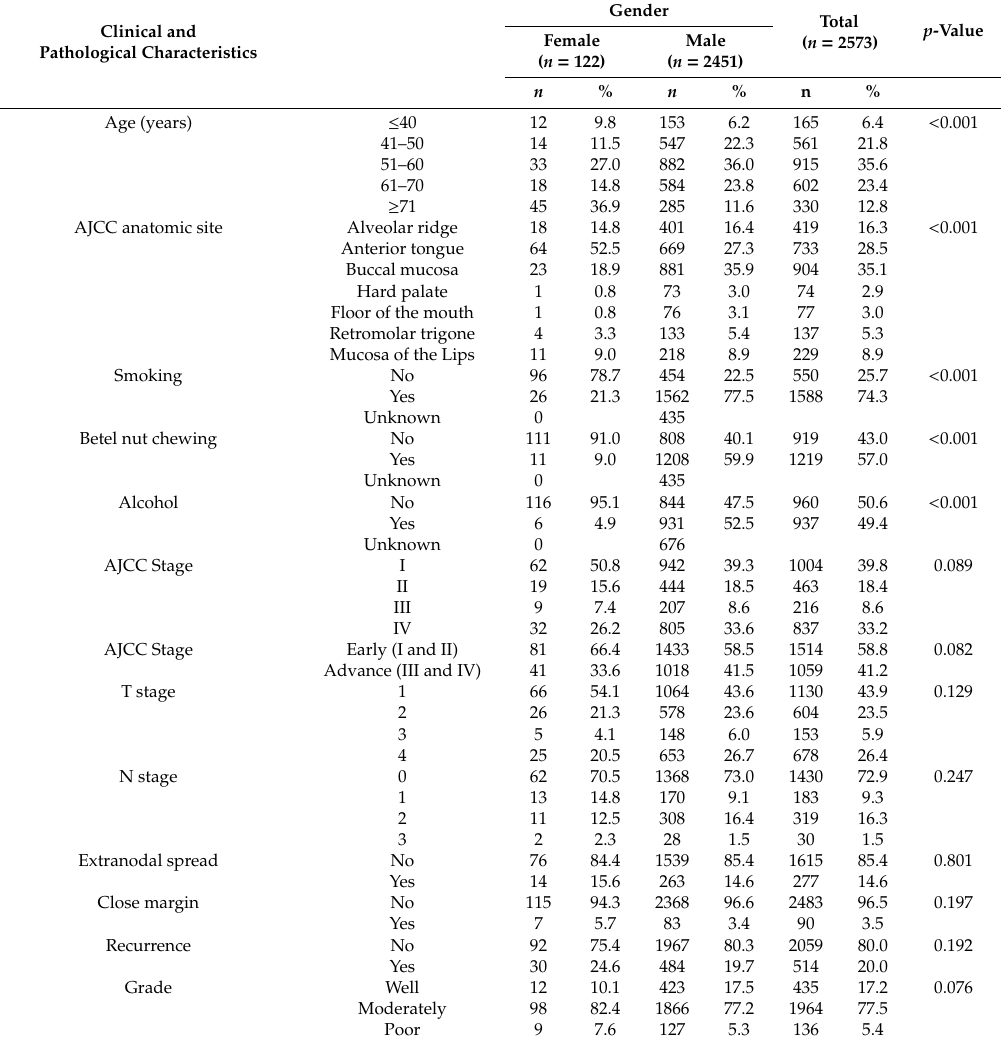
Table 2. Stratified data including age at diagnosis and clinical and pathological characteristics of all patients; AJCC: American Joint Committee on Cancer; p -value was tested by chi-square test. Clinical and Pathological